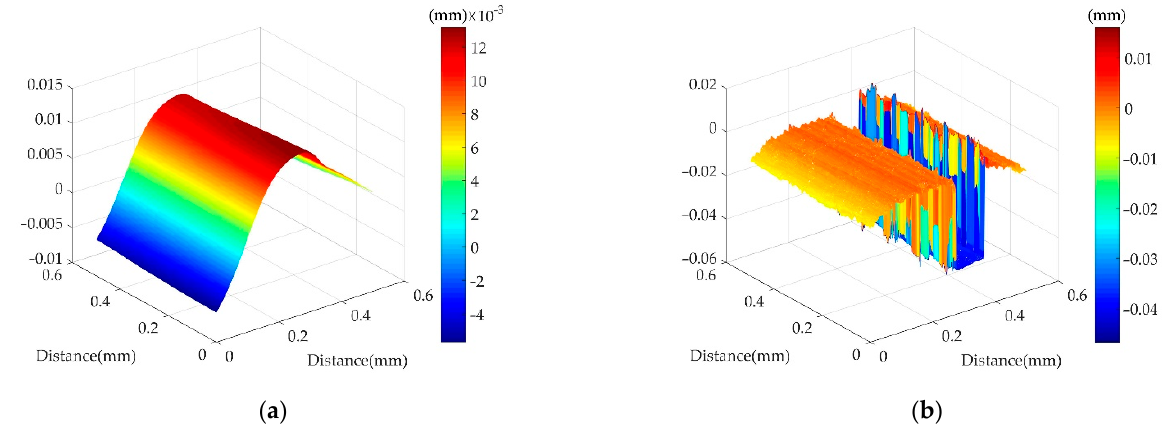
Figure 15. ( a ) Waviness surface and ( b ) roughness surface after using the RGRF filter. Figure 16. ( a ) Waviness surface and ( b ) roughness surface after using the ADRF filter. Table 8. Roughness parameter values after using the ADRF and RGRF filter.